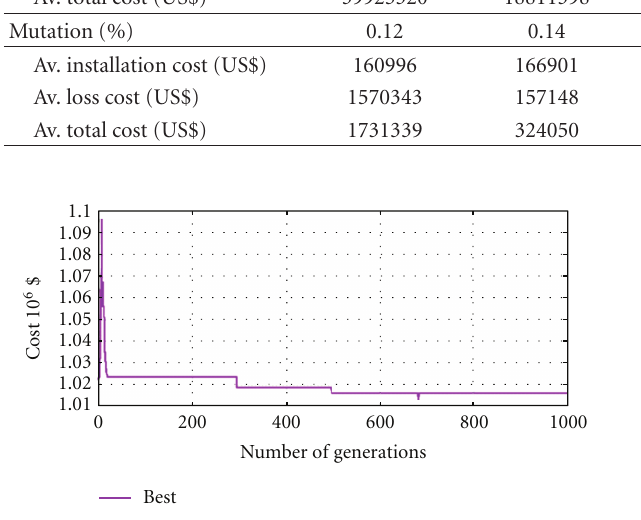
Figure 2: Cost versus number of generations.